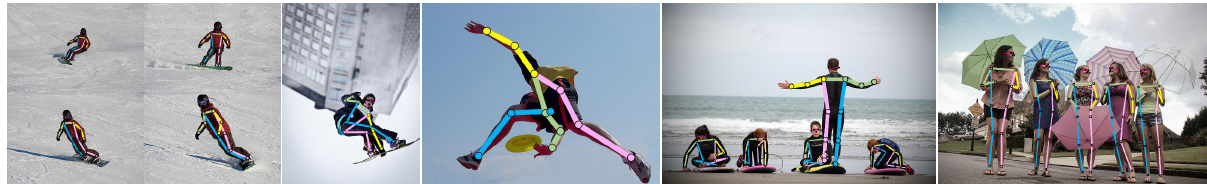
Figure 6. Presentation for COCO: including viewpoint change, occlusion, and multiple persons.